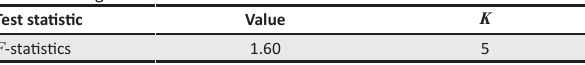
TABLE 4a: Bound test for the presence of co-integration in auto-regressive distributed lag. Test statistic Value K F -statistics